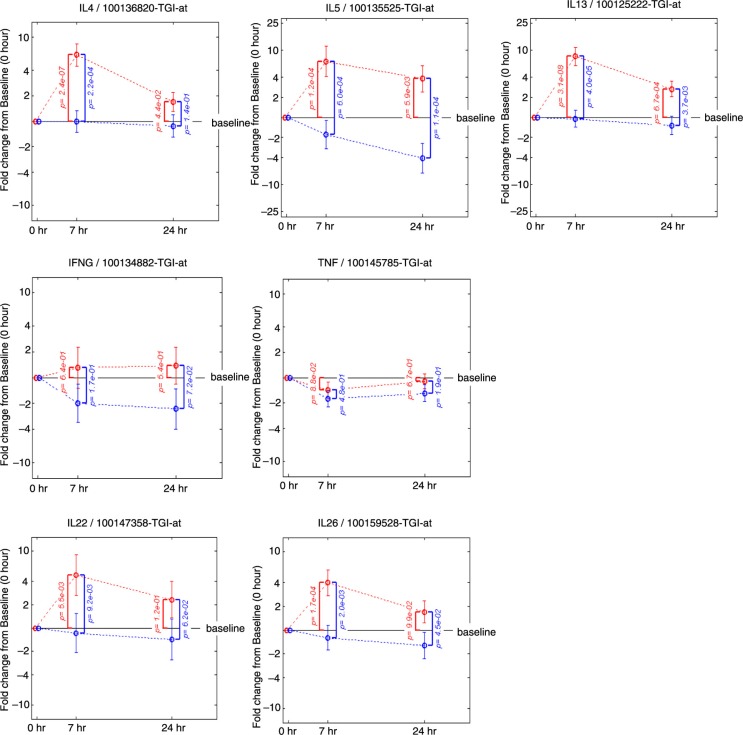
Fold change from baseline in gene expression. Th2 mRNA levels (IL4, IL5, IL13), Th1 mRNA levels (IFNG and TNF), Th17 mRNA levels (IL22, IL26). Fold change from baseline for the placebo group is represented in red. Fold change from baseline for the fluticasone group is represented in blue. p Values are adjusted p values; error bars represent 90% confidence intervals.